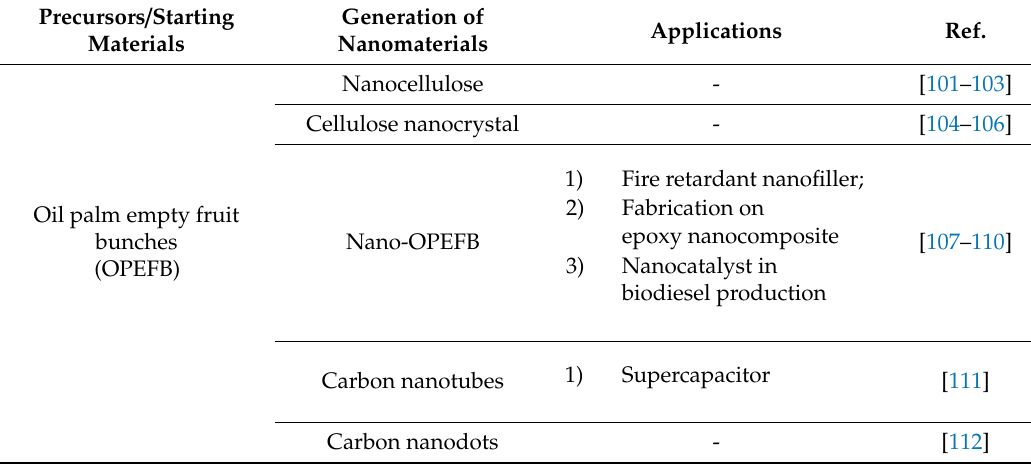
Table 3. Generation of nanomaterials extracted from oil palm biomass